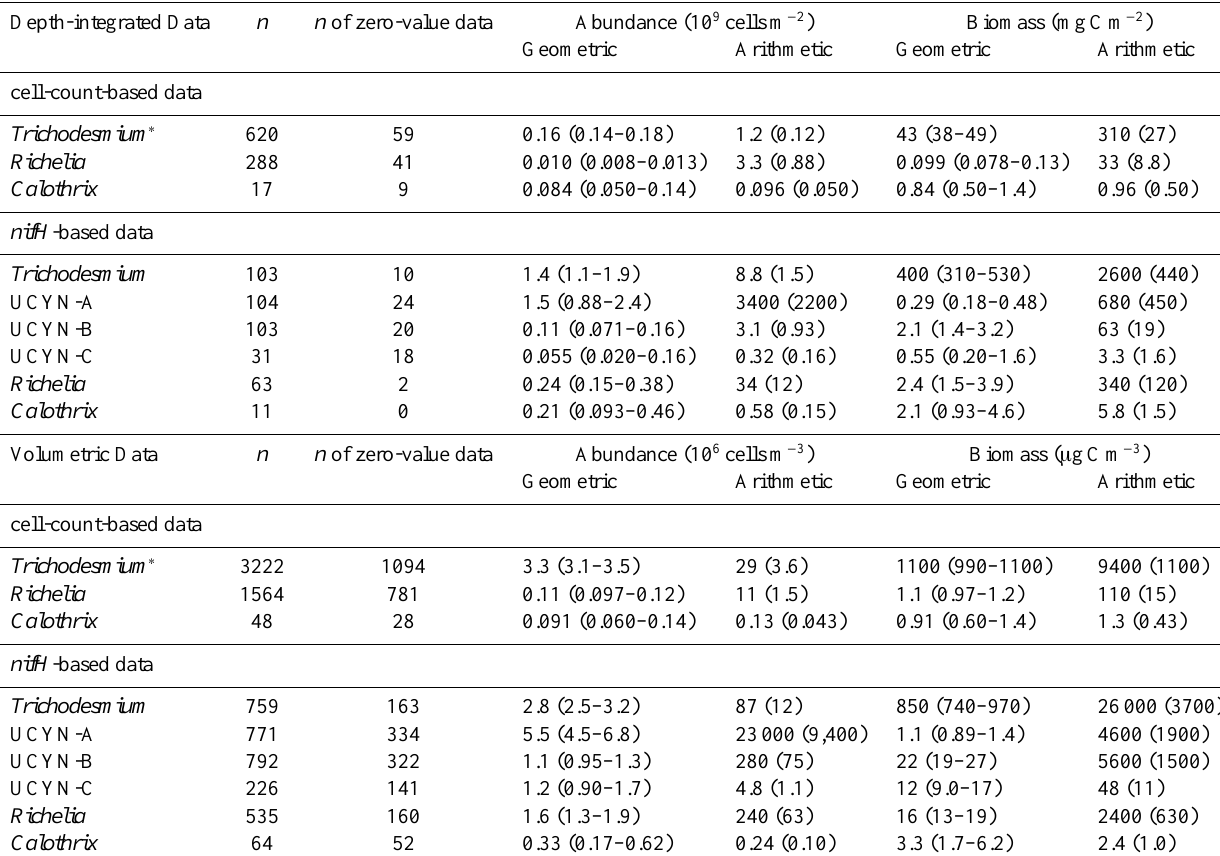
Table 5. Abundances and estimated biomass (using default conversion factors in Table 2) of each diazotrophic group from cell counts and nifH -based data, shown by geometric and arithmetic mean. Note that data points with zero-values are excluded when calculating geometric means. Error ranges for geometric means shown in parentheses are estimated by dividing and multiplying the geometric means by one geometric standard error. Standard errors for arithmetic means are shown in parentheses. Depth-integrated and volumetric data points are analyzed